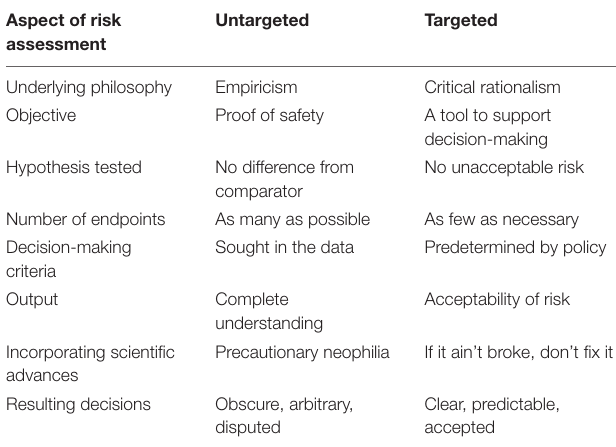
TABLE 1 | A comparison of targeted and untargeted approaches to risk